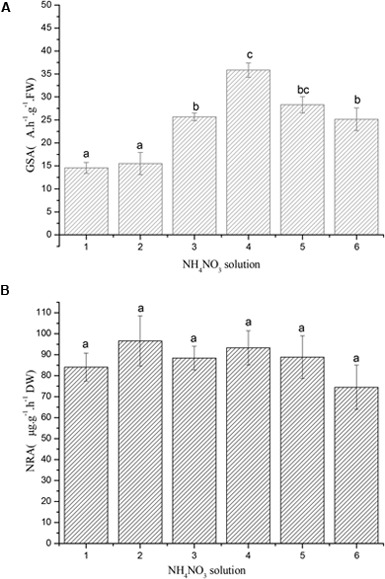
(A) Response of glutamine synthetase activity (GSA) of R. calicaris var. japonica to nitrogen addition (Mean ± SD, n = 3). Code of horizontal axis represented 0.1, 0.2, 0.4, 0.8, 1.6, and 2.0 mM NH4NO3 solution, respectively. Vertical bars indicate standard deviation. Different lowercases indicate significant differences using the Tukey test (significance level at p < 0.05). (B) Response of nitrate reductase activity (NRA) of R. calicaris var. japonica to nitrogen addition (Mean ± SD, n = 3). Code of horizontal axis represented 0.1, 0.2, 0.4, 0.8, 1.6, and 2.0 mM NH4NO3 solution, respectively. Vertical bars indicate standard deviation. Different lowercases indicate significant differences using the Tukey test (significance level at p < 0.05).